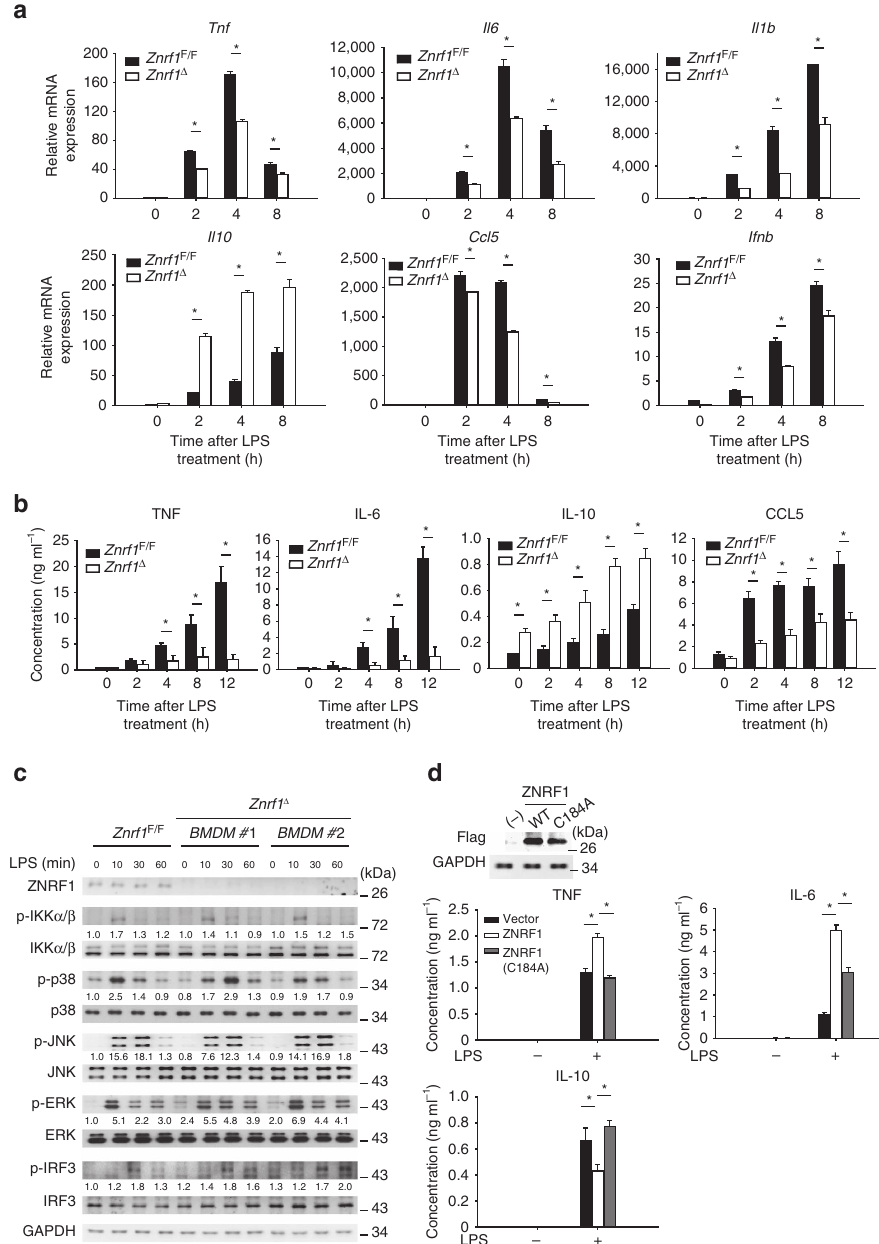
Figure 1 | ZNRF1 deletion impairs LPS-induced production of inflammatory mediators in BMDMs. ( a – c ) BMDMs were harvested from wild-type ( Znrf1 F/F ) or Znrf1 D mice and treated with LPS (100ngml (cid:2) 1 ) for the indicated times. ( a ) The expression of the indicated mRNAs was analysed by RT–qPCR. ( b ) The production of cytokines in supernatants was determined by ELISA. ( c ) The phosphorylation of MAPKs, IKK a / b , IRF3 as well as the indicated proteins in cell lysates was analysed by immunoblot analysis. The intensities of the bands are expressed as fold increases compared to those of untreated control cells after normalization to their unphosphorylated forms. ( d ) BMDMs from Znrf1 D mice were reconstituted with either Flag-tagged wild-type ZNRF1 or ZNRF1(C184A) mutant and stimulated with LPS (100ngml (cid:2) 1 ) for 8h. The levels of the indicated cytokines in culture supernatants were measured by ELISA. * P o 0.05 (Student’s t -test). The data are representative of three independent experiments performed in triplicate (error bars,